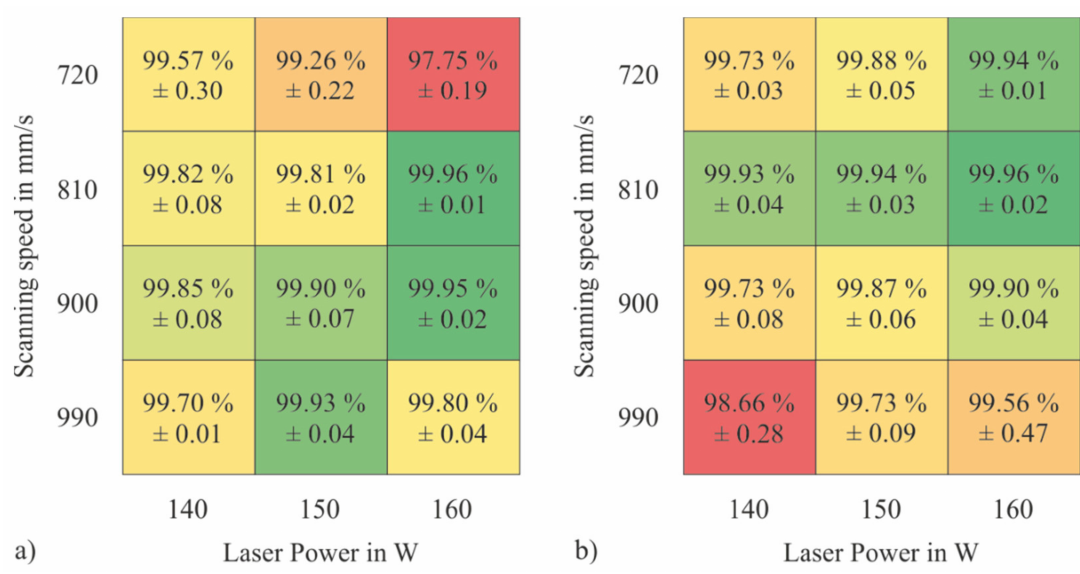
Figure 9. Relative densities of PBF-LB/M-samples manufactured at different process